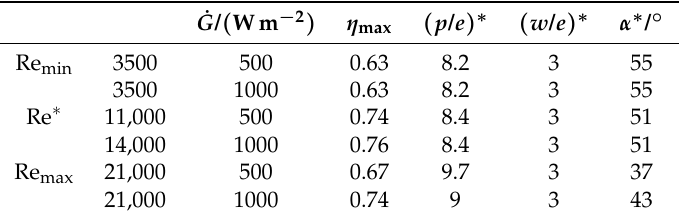
Table 15. Maximum efficiency and optimum roughness parameters according to the model developed by Kumar and Layek [28].